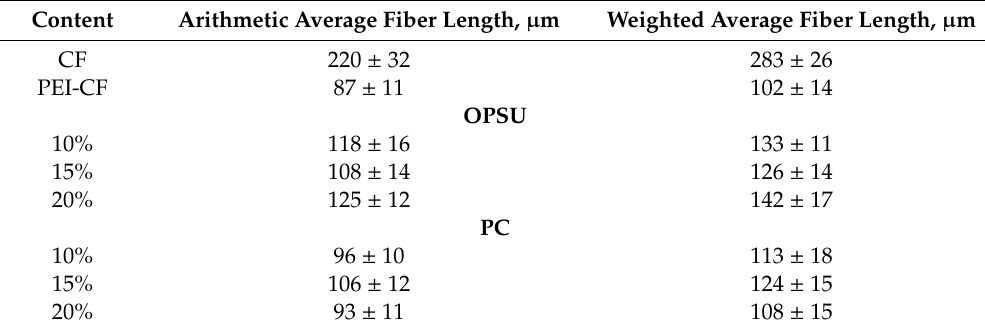
Table 5. The dependence of the residual linear particle size of CF on the content of the OPSU and PC.